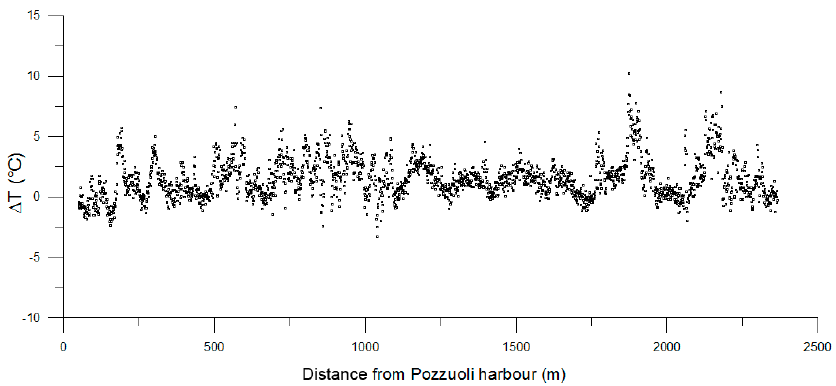
Figure 7. Temperature difference along the fiber-optic cable, recorded between January and April 2016.